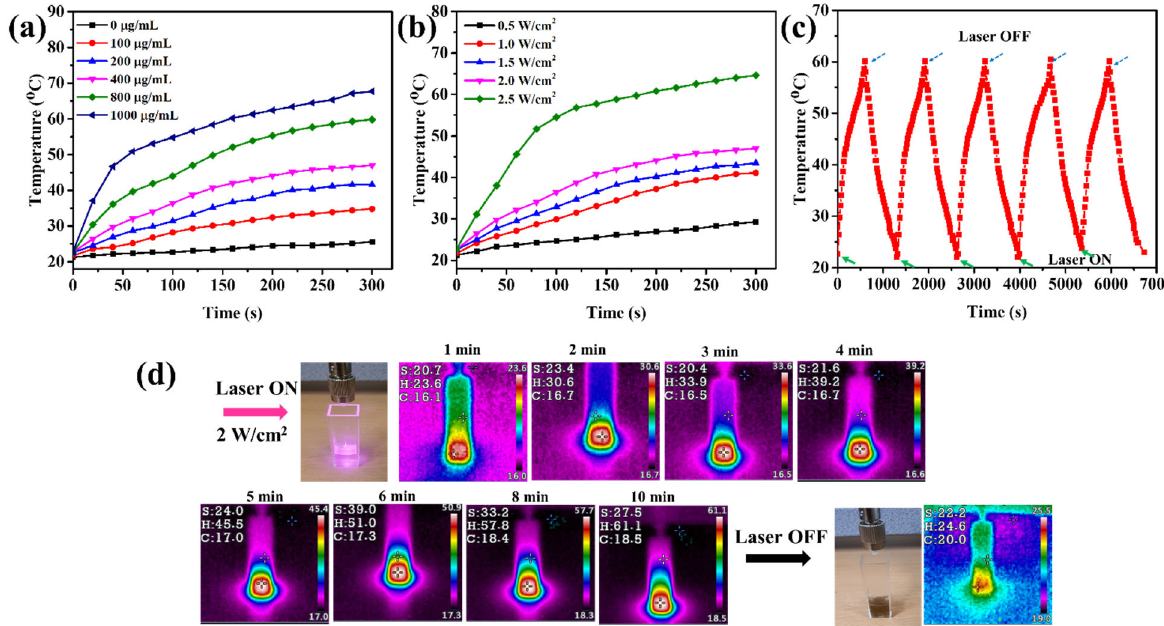
Figure 3. Photothermal heating kinetic graphs of FCPDA nanoparticles at ( a ) different concentrations, ( b ) different power densities, ( c ) heating and cooling cycles with or without NIR laser treatment, and ( d ) infrared photographs of FCPDA nanoparticle illumination under 808 nm laser at 2 W/cm 2 with respect to